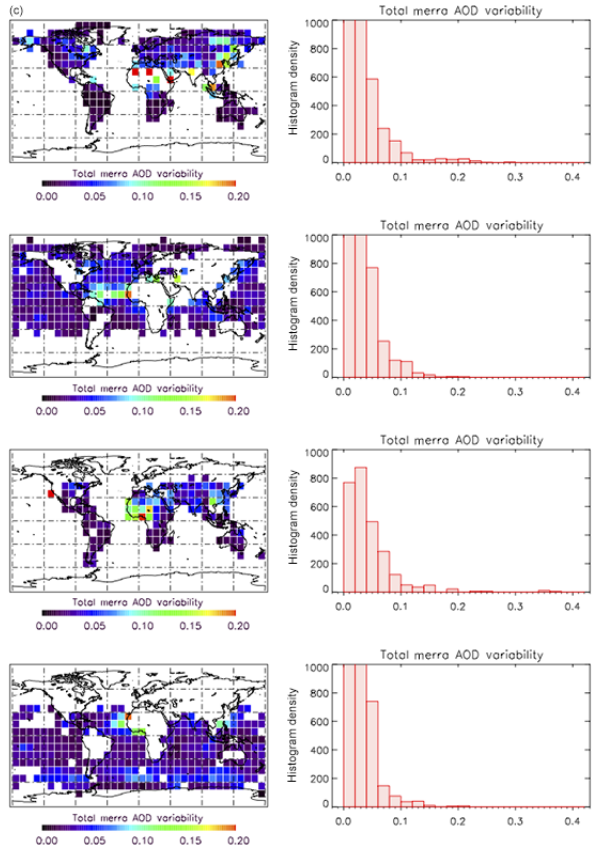
Figure 4. (c) Monthly standard deviation of aerosol optical depth (AOD) from MERRA. Top: June, land; second row: June, ocean; third row: Dec. land; bottom: Dec., ocean. (Table 2), but the sensitivity of XCO 2 to the ILS is high. Er- ror due to the ILS is larger and much more variable over land than over ocean.